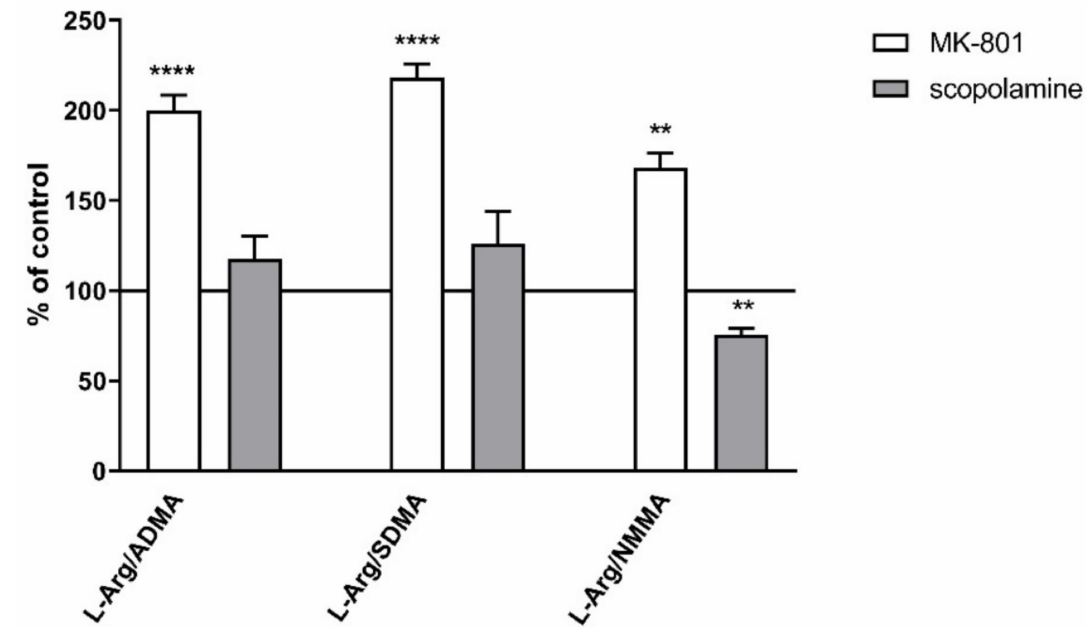
Figure 18. L-arginine (L-Arg)/ADMA, L-arginine/SDMA and L-arginine/NMMA ratios in plasma after chronic (14 days) administration of MK-801 (0.3 mg/kg) or scopolamine (1 mg/kg). Data are presented as means ± SEM. ** p < 0.01; **** p < 0.0001 vs. control.